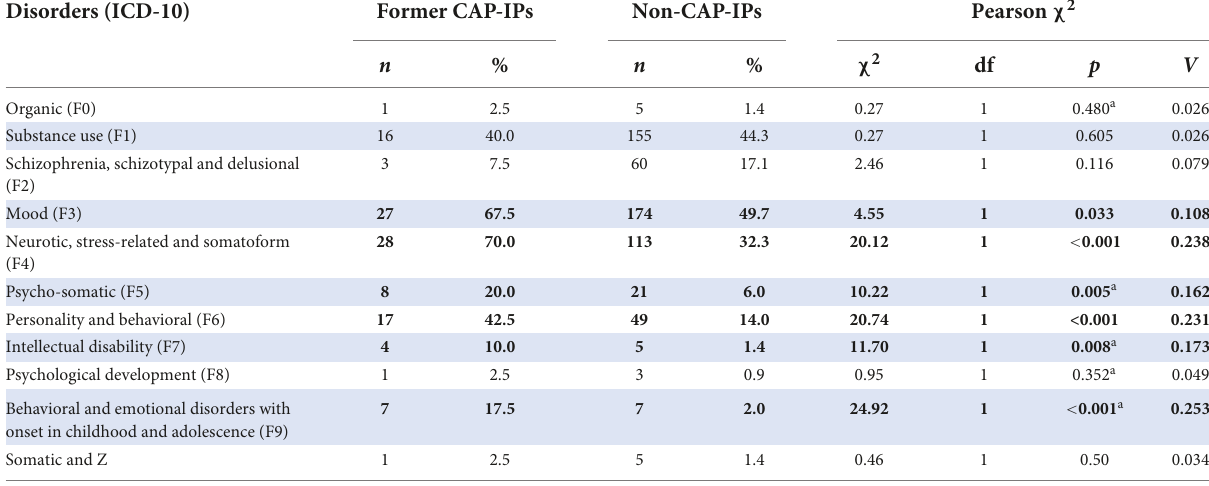
TABLE 5 Comparison of the primary and secondary ICD-10 diagnosis received at any psychiatric inpatient treatment ( n , %, Pearson χ 2 ) in young adult inpatients with a former child- and adolescent psychiatric inpatient treatment (former CAP-IPs) and those without it (non-CAP-IPs). Disorders